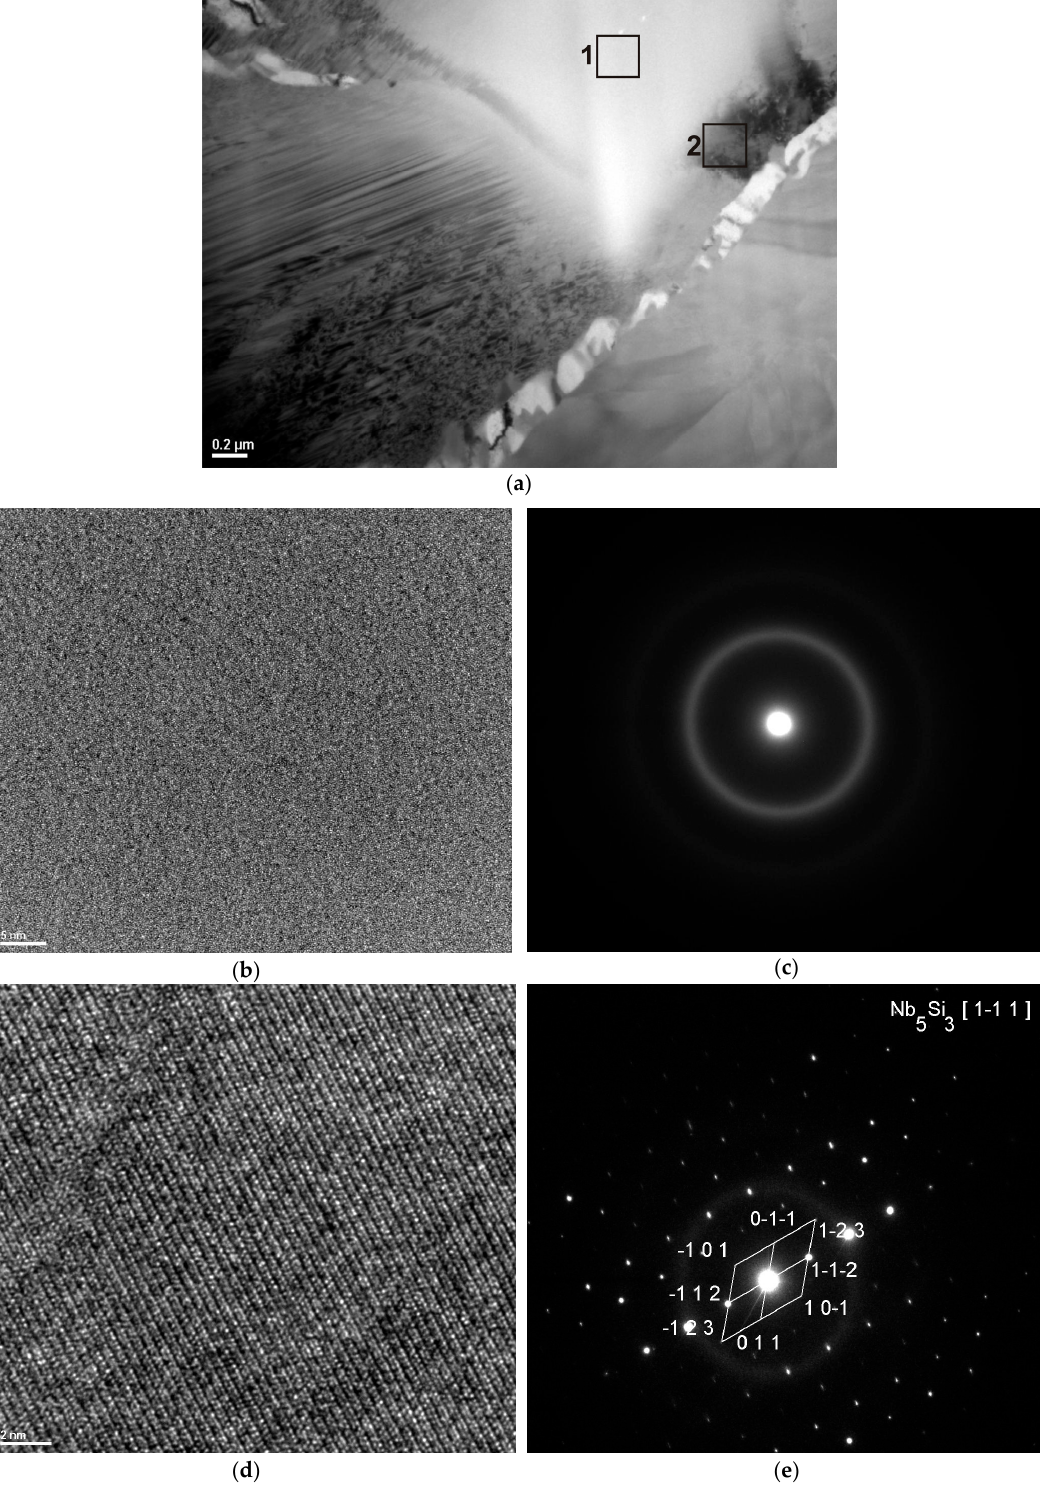
Figure 7. Transmission electron microscopy (TEM) images of the Fe 36.00 Co 36.00 B 19.00 Si 5 Nb 4 alloy in rod form with the diameter of 2.5 mm: ( a ) bright field; ( b ) HRTEM image of the position marked 1 in (a) at higher magnification; ( c ) electron diffraction, an amorphous phase; ( d ) HRTEM image of the position marked 2 in (a) at higher magnification; ( e ) electron diffraction with solution, precipitate of the Nb 5 Si 3 phase.